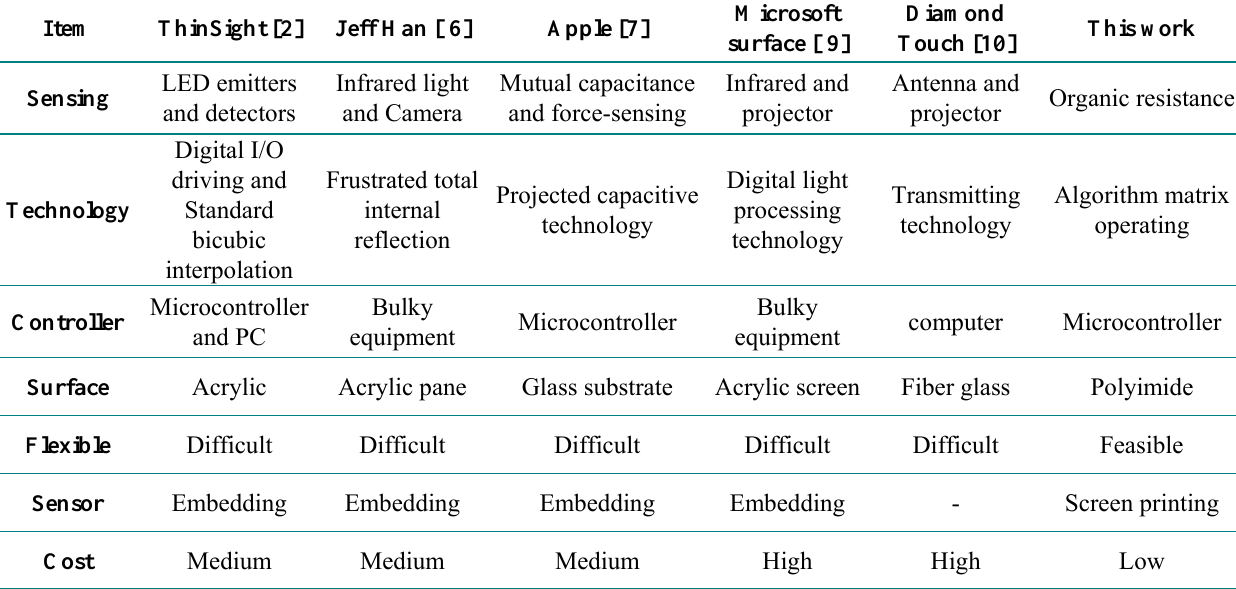
Table 1. Comparison of multi-touch